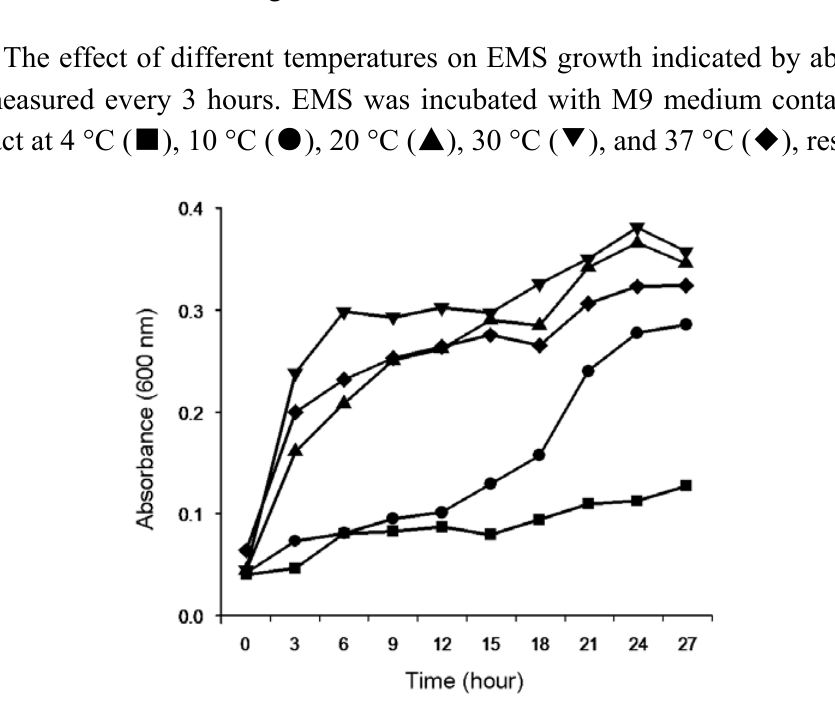
Figure 4. The effect of different pH values on EMS growth indicated by absorbance at 600 nm measured every 3 hours. EMS was incubated with M9 medium containing crude MCs extract with pH values at 5.0 ( ■ ), 6.0 ( ● ), 7.0 ( ▲ ), 8.0 ( ▼ ), and 9.0 ( ◆ ),